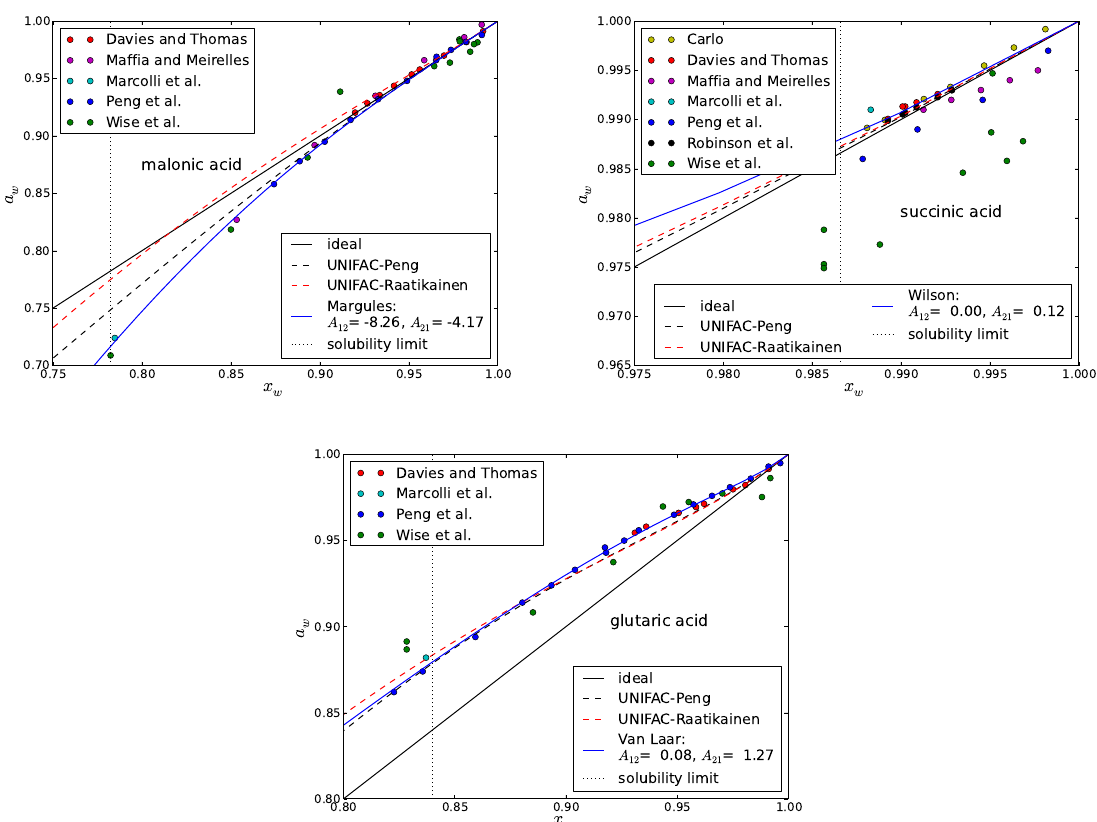
Fig. A1. Water activity of malonic, succinic and glutaric acids in the subsaturation region. Mixture-specific fitted expressions and group- Fig. 6. Water activity of malonic, succinic and glutaric acid in the subsaturation region. Mixture-specific contribution activity estimations are also fitted expresssions and group-contribution activity estimations are also indicated.